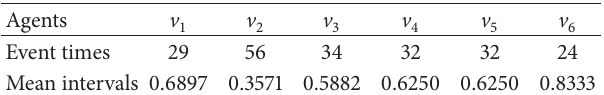
Table 2: Mean event intervals for the agents during 𝑡 ∈ [0, 20] in Example